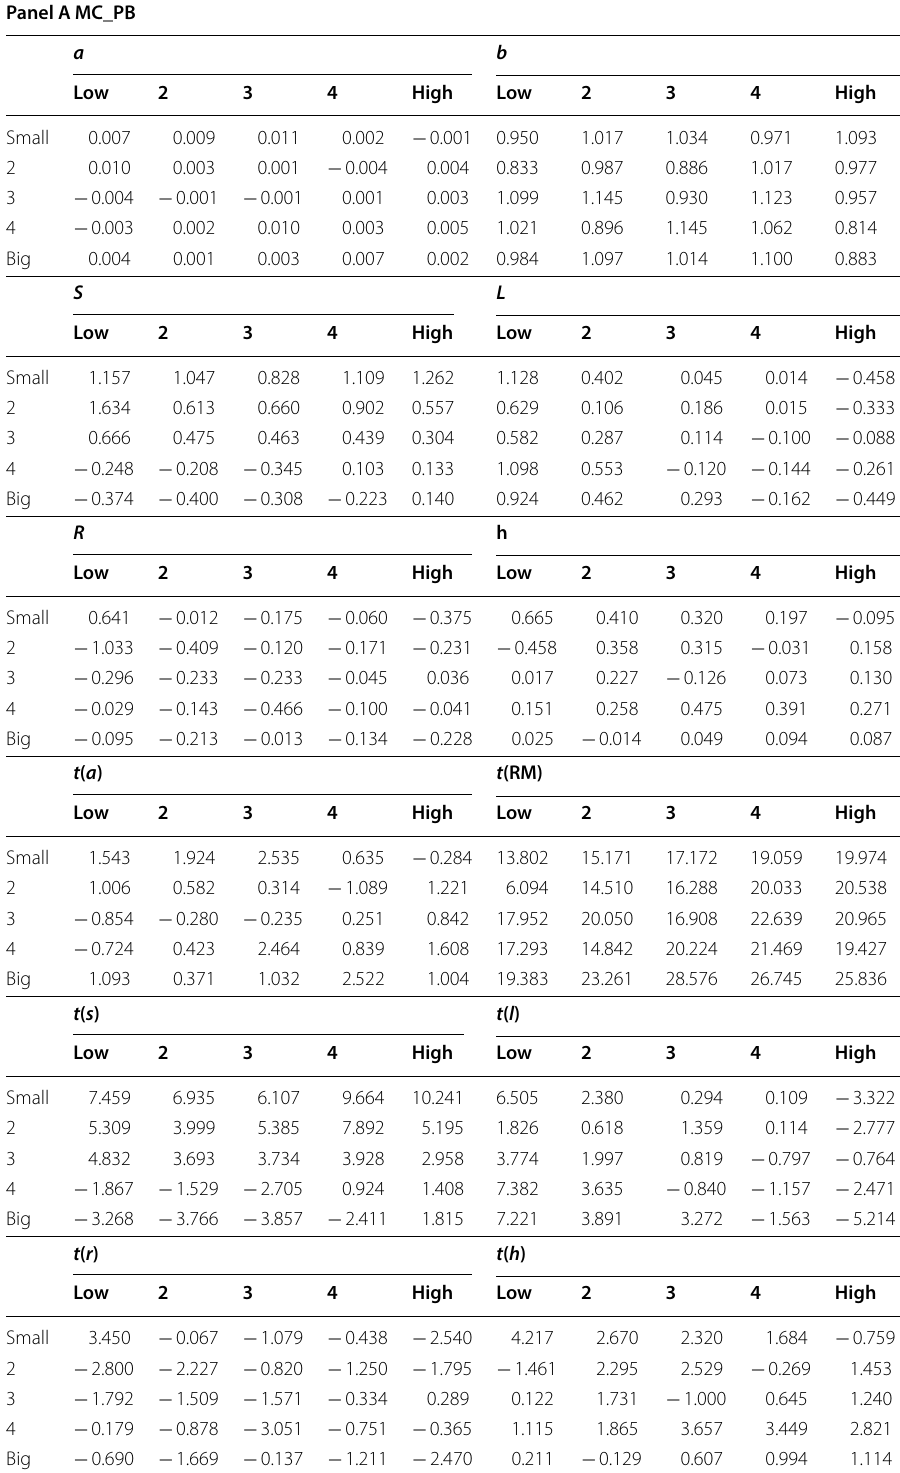
Table 6 Regression results of Modified Five-Factor Model with human asset for